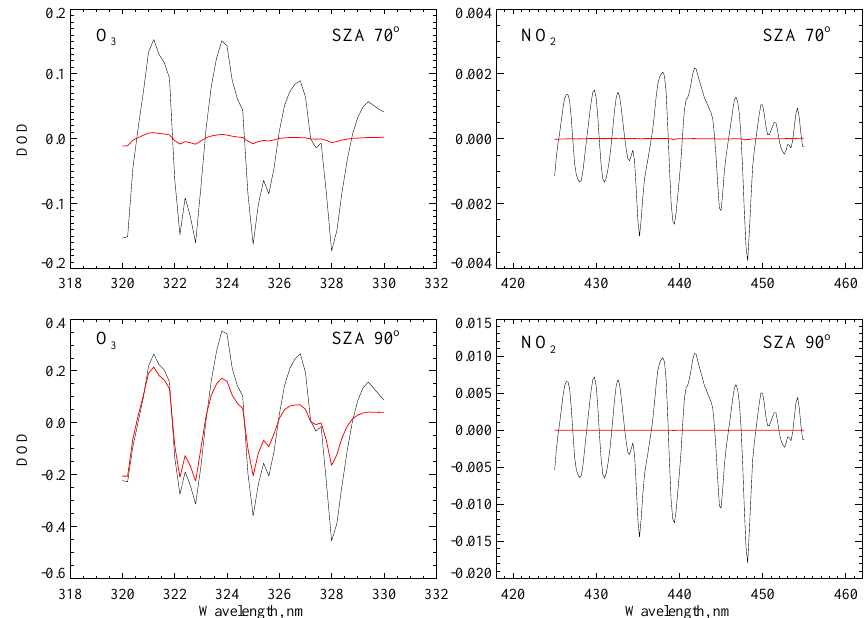
Fig. 3. Linearization error ε lin ,j (λ) according to Eq. (108) in absorption bands of O 3 (left panels) and NO 2 (right panels) at solar zenith angles of 70 ◦ (upper panels) and 90 ◦ (lower panels). Red curves show the linearization error whereas black curves denote the differential (k) , see Eq. slant optical thickness of the absorbing species, − L d λ,j